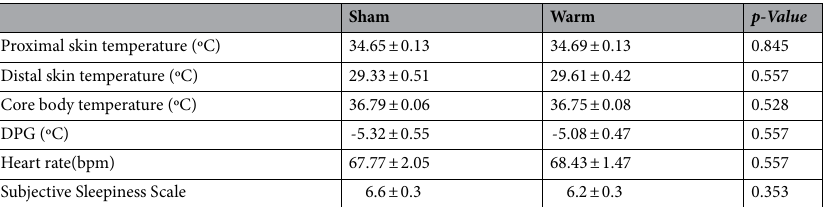
Table 1. Baseline body temperature, heart rate, and subjective sleepiness scale. All are values expressed as mean ± SEM of eighteen subjects. Comparisons were performed relative to the sham condition using the Wilcoxon signed rank test. DPG, distal–proximal skin temperature